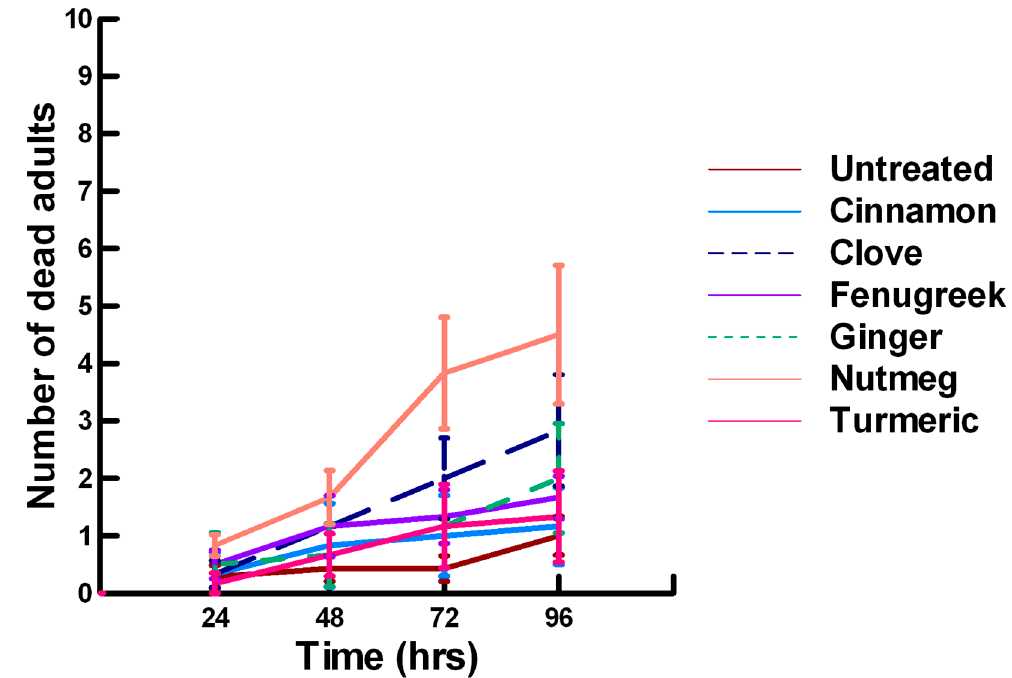
Figure 13. Acute contact toxicity with a high concentration of plant powders from the families Lauraceae (cinnamon), Myrtaceae (clove), Fabaceae (Fenugreek), Myristicaceae (nutmeg) and Zingiberaceae (ginger, turmeric) adherent to male adult Megachile rotundata (ALBs). Means and standard error shown.